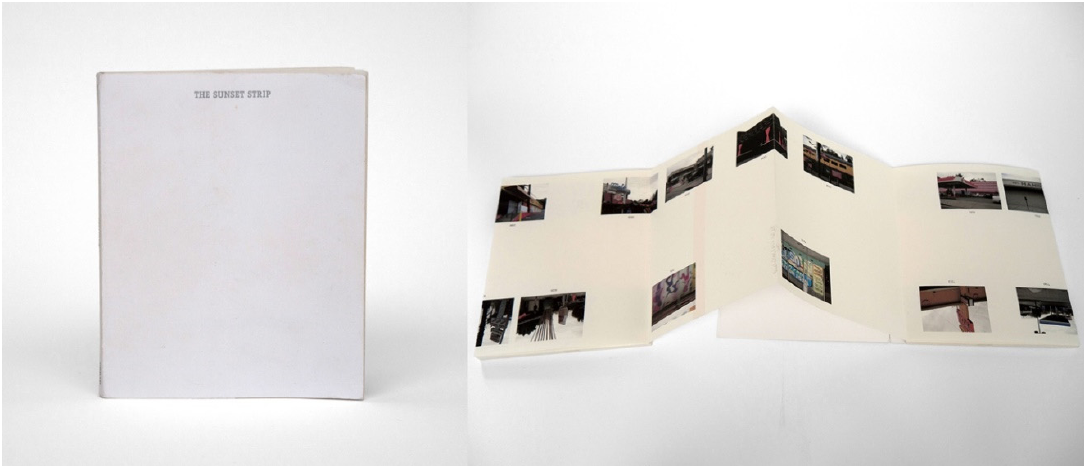
Figure 32. Tom Sowden, Some of the Buildings on Sunset Strip , 2008.